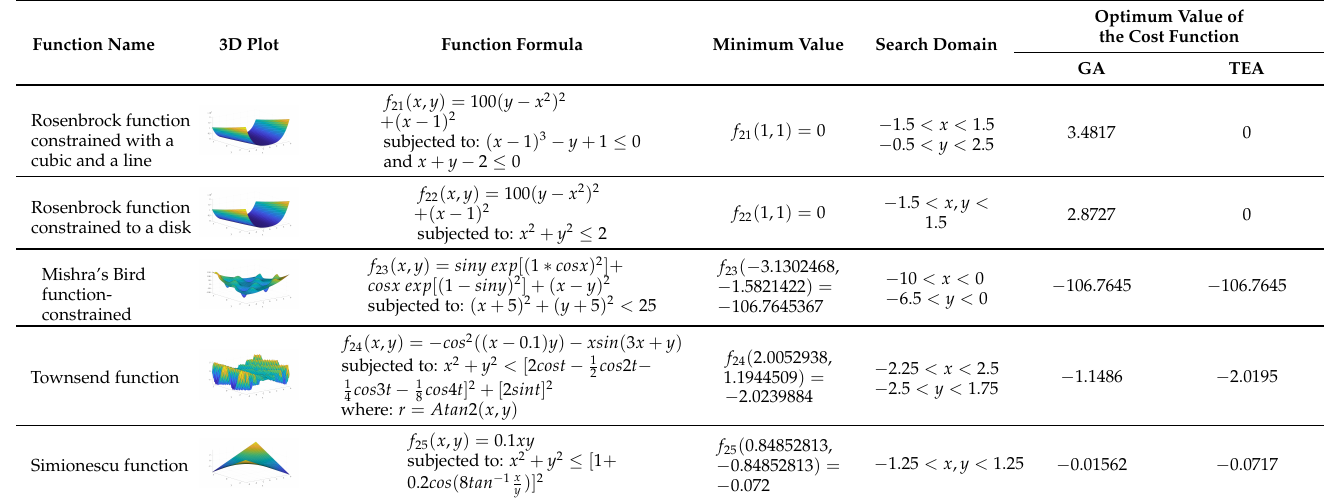
Table 2. Details of the functions